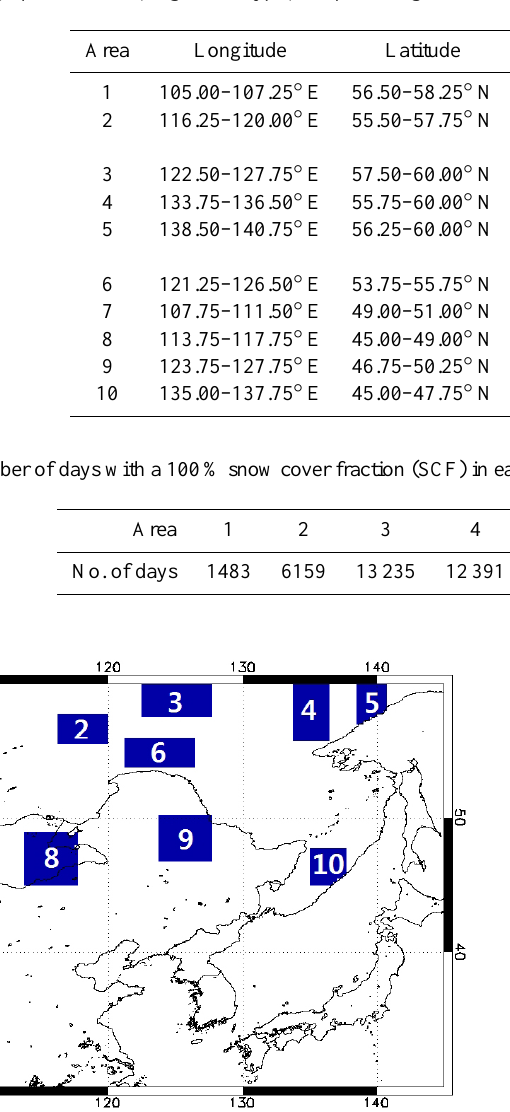
Table 2. Geographic location, vegetation type, and percentage of dominant vegetation type for selected areas.